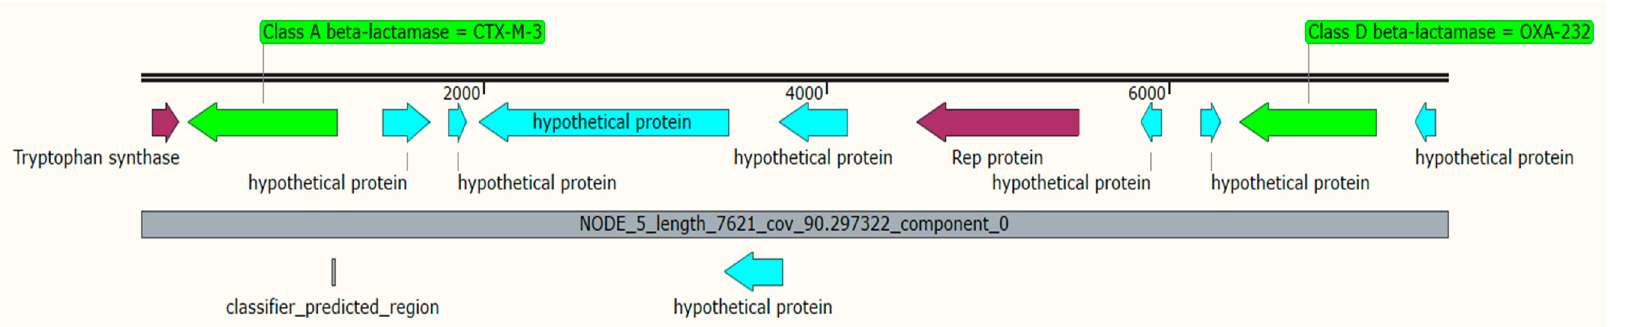
Figure 2. A cluster of antimicrobial resistance genes in the plasmid p ColKP3 of isolate K6. The green colors show the bla CTX-M-3 and bla OXA-232 , while the replication initiation gene is shown in violet color.